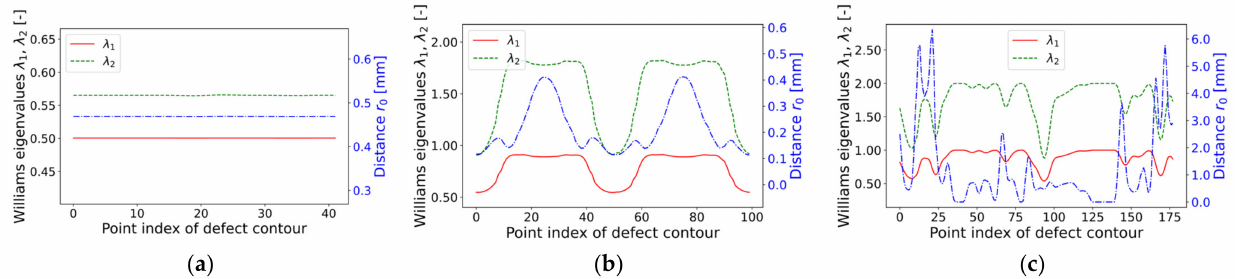
Figure 9. William’s eigenvalues and control volume distance for three defect geometries: ( a ) Circular hole-in-plate (mesh ‘circle_lin_R1mm_v1’); ( b ) Elliptical hole-in-plate (mesh ‘ellipsis_lin_rot0deg_v1’); and ( c ) Elongated defect (mesh